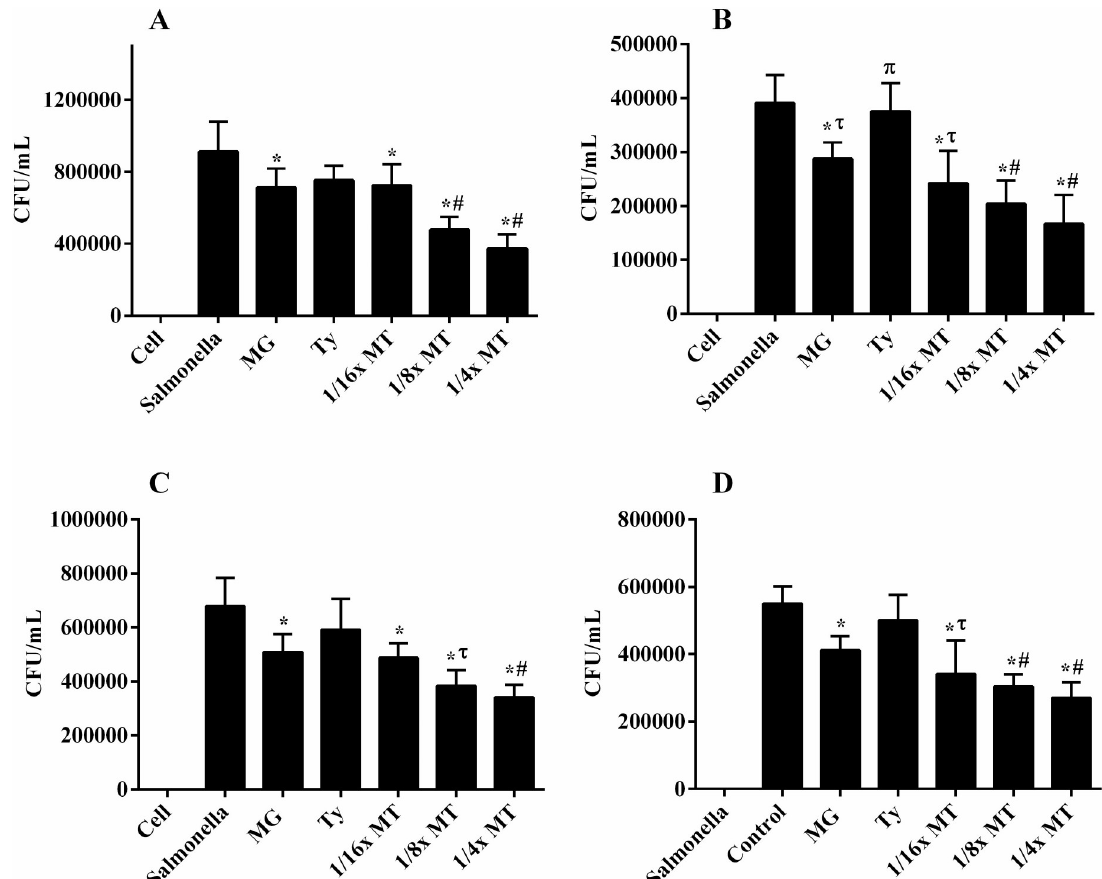
Fig 7. Effects of methyl gallate (MG), tylosin (Ty) and various concentrations of their combination (MT) on the adhesion and invasion of S . Typhimurium ATCC 14028 (A and C) and S . Typhimurium LVPP-STI15 (B and D) to CaCo-2 intestinal epithelial cells. Cell: non-infected and non-treated control. Salmonella : S . Typhimurium infected, but non-treated cells. Values represent mean ± SEM of six independent experiments. MG = 32 μ g/mL; Ty = 64 μ g/mL; 1 / 16 × MT = 8 μ g/mL MG and 16 μ g/mL Ty; 1 / 8 × MT = 16 μ g/mL MG and 32 μ g/mL Ty; and ¼× MT = 32 μ g/mL MG and 64 μ g/mL Ty. � P < 0.05 compared to infected, but non-treated cells; τ P < 0.05 compared to Ty; π P < 0.05 compared to MG; and # P < 0.05 compared to both MG and Ty. The effects of MG (8, 16 and 32 μ g/mL) and Ty (16, 32 and 64 μ g/mL) were not concentration-dependent.